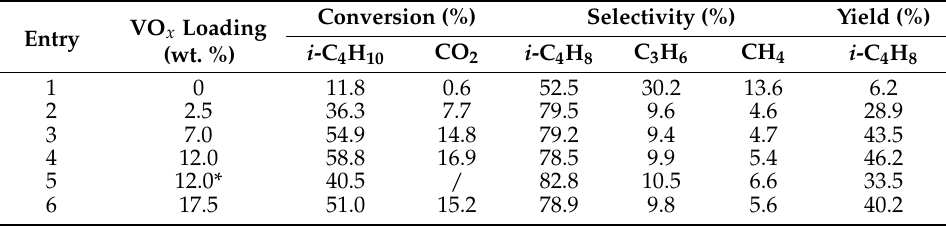
Table 2. Catalytic performance for isobutane dehydrogenation over VO x /MSU-1 with different VO x